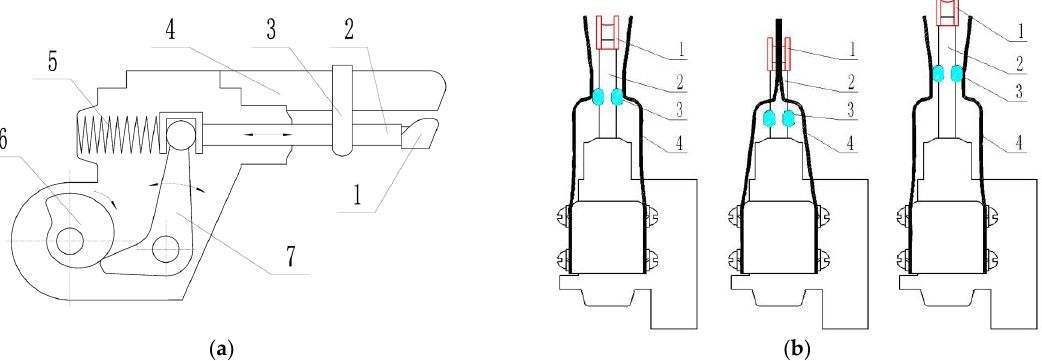
Figure 2. ( a ) Transplanting arm; ( b ) Clip seedling device. The following parts are shown: 1, seedling pushing device ; 2, seedling pushing rod ; 3, clip seedling device ; 4, seedling piece ; 5, push the seedling spring; 6, CAM; 7,